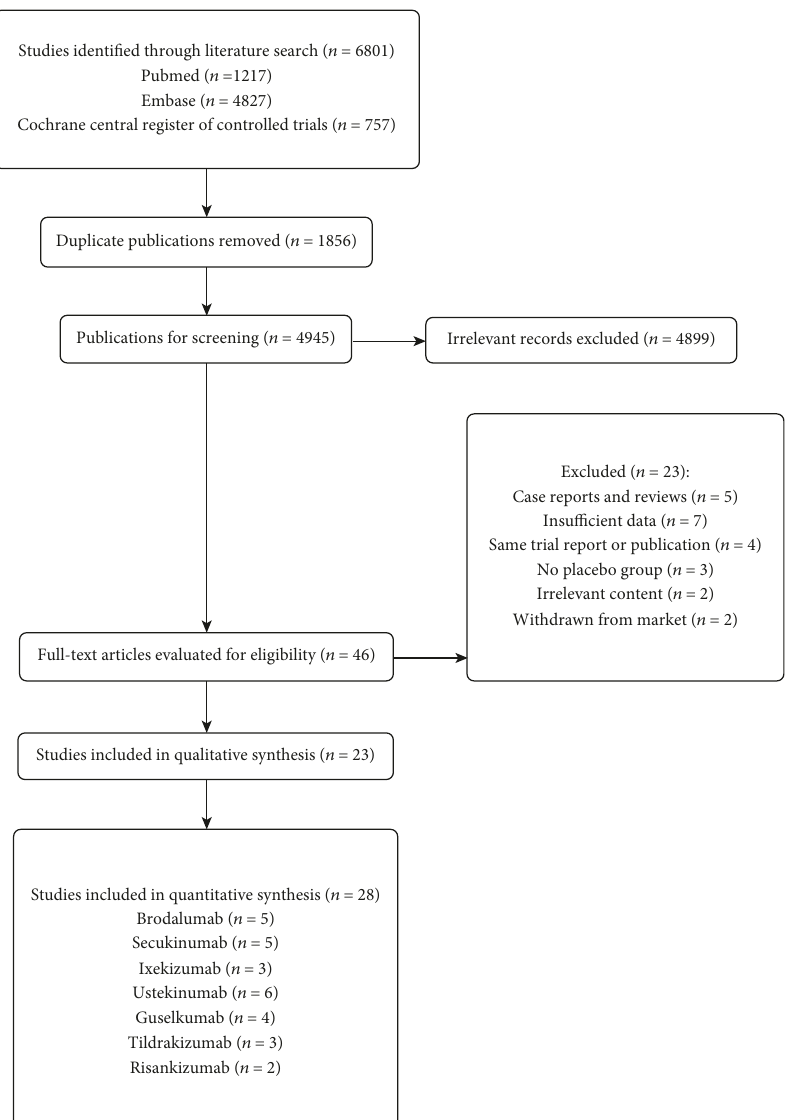
Figure 1: Flowchart for the selection of eligible